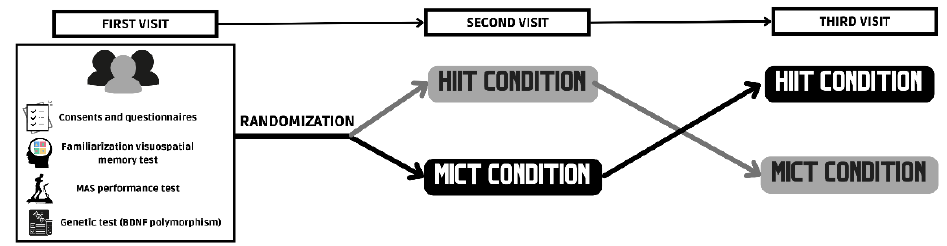
Figure 1. Study design.